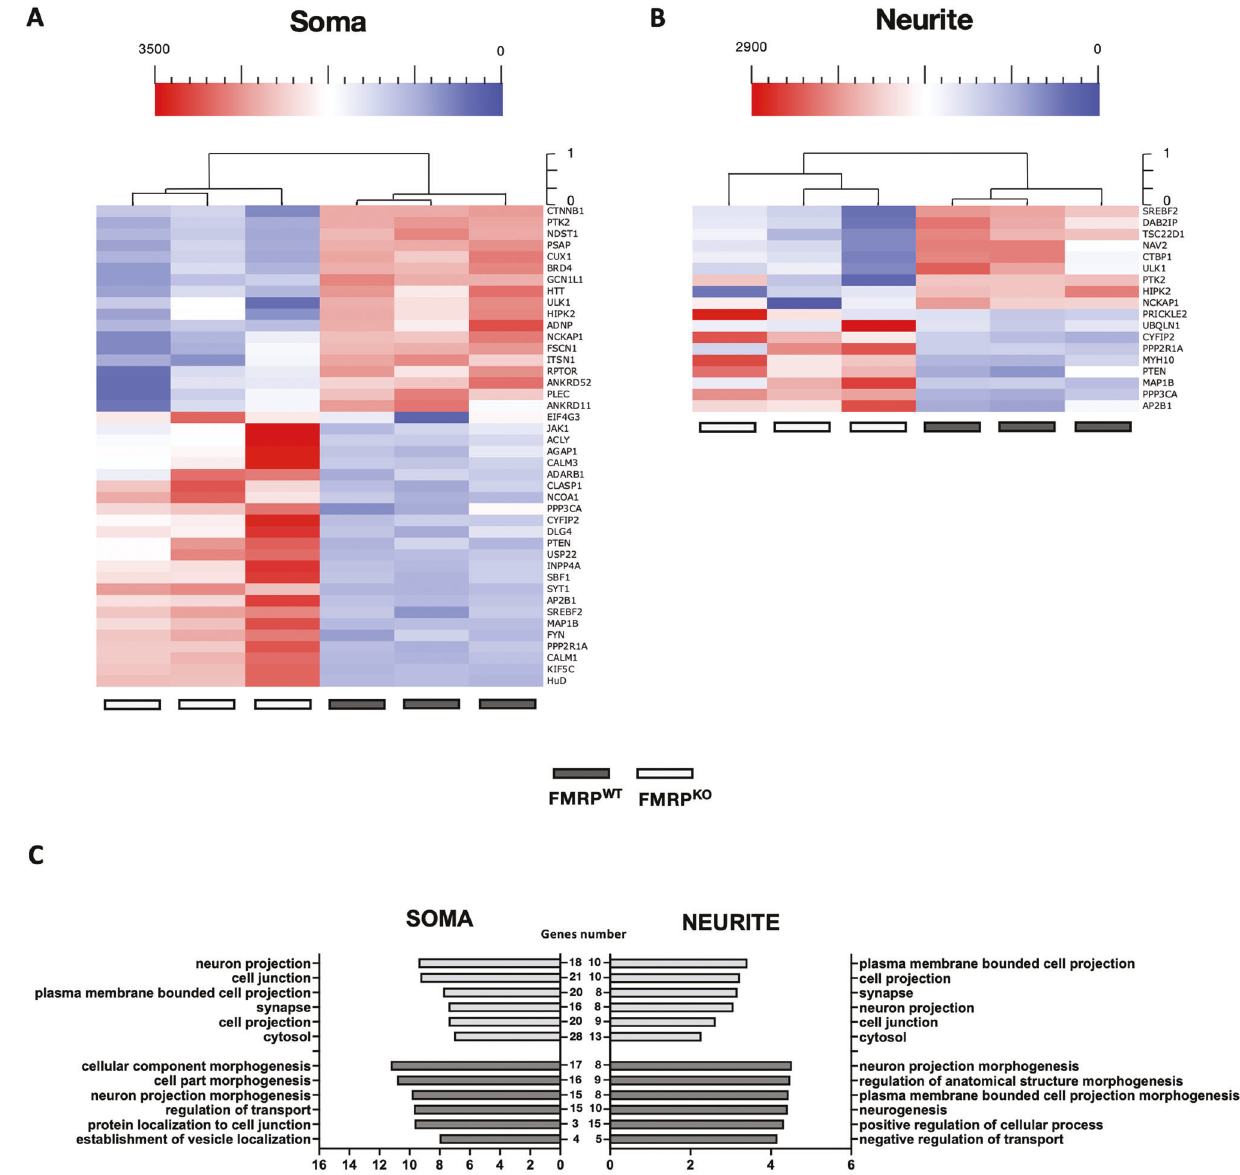
Fig. 3 Differentially expressed genes in soma and neurite of FMRP WT and FMRP KO MNs. A , B Unsupervised cluster representing the RNA molecules count of differentially expressed genes in the cell body ( A ) or neurite ( B ) compartment of iPSC-derived FMRP WT and FMRP KO MNs. Plotted values correspond to normalized RNA molecules as described in the Methods section. Red, higher abundance; blue, lower abundance. C Bar graph representation of the top 6 GO terms enriched in differentially expressed genes as in ( A , B ). The − log10(adjusted p -value) and number of genes are